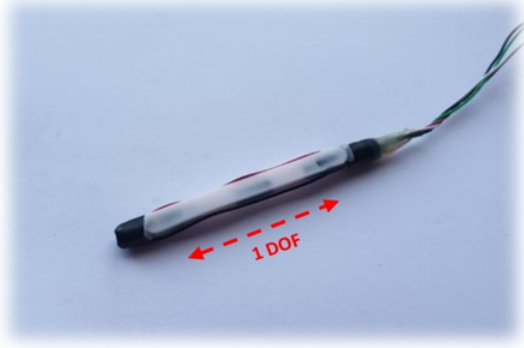
Figure 10. Fiber optic sensor.